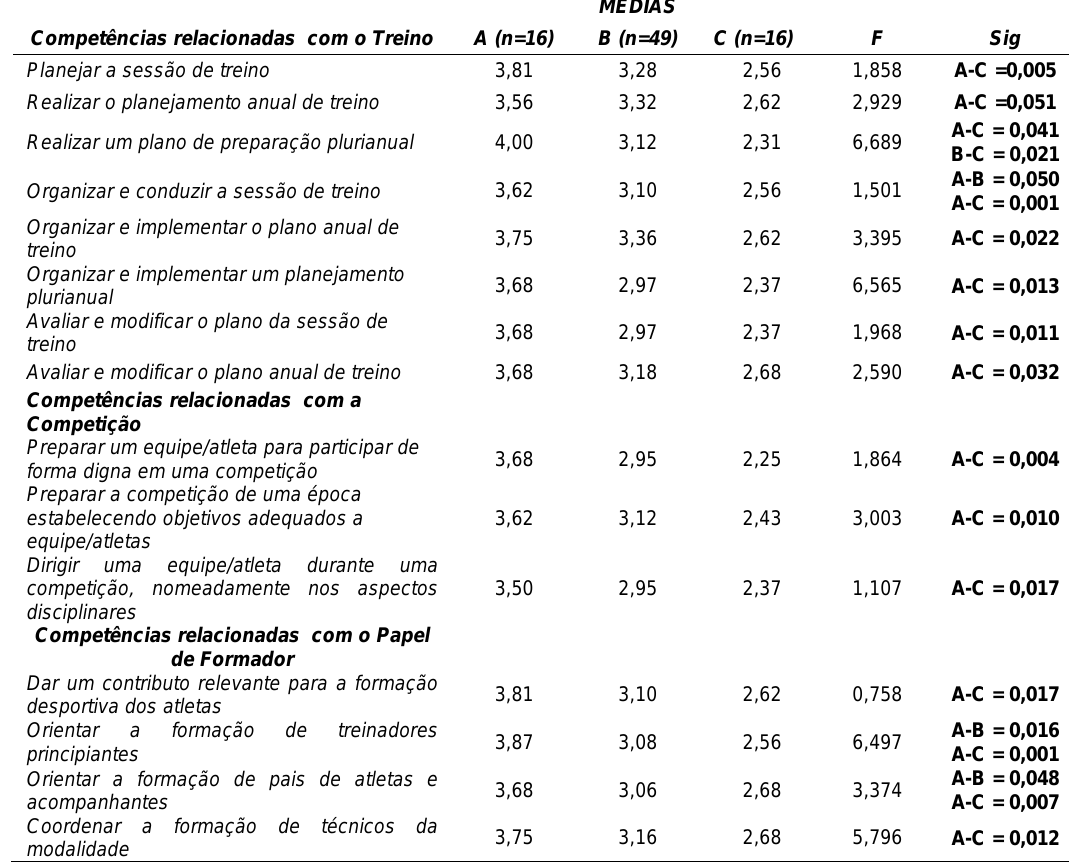
Tabela 2. Análise comparativa das necessidades de formação dos treinadores em relação as competências relacionadas com o Treino, Competição, Gestão Desportiva e Papel de Formador em função dos níveis de formação